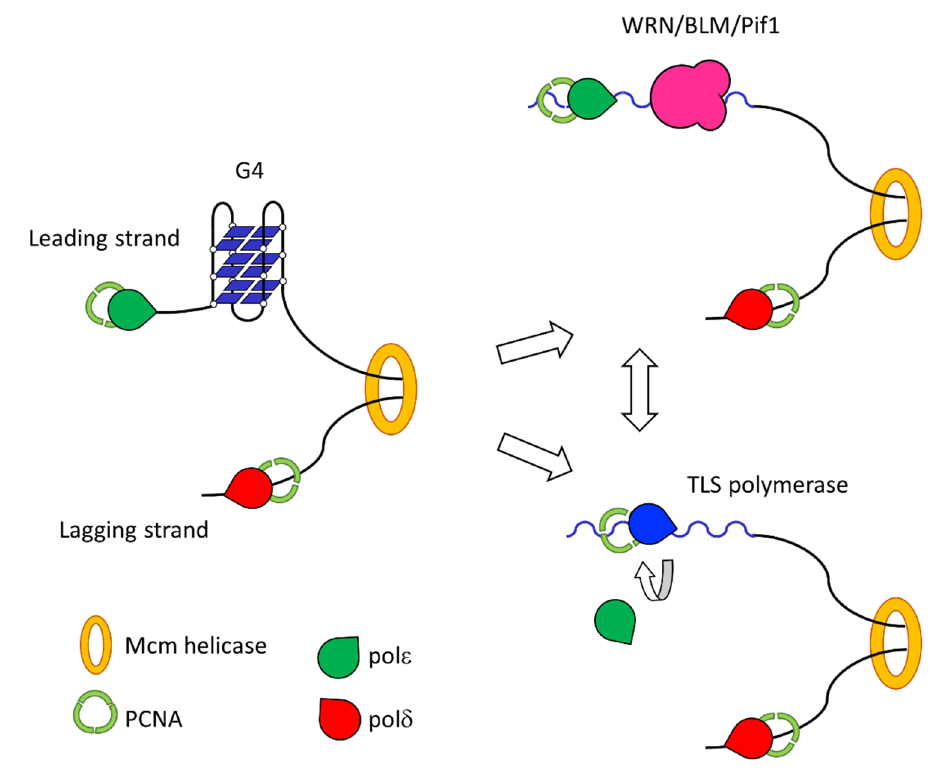
Figure 4. Resolution of G4 motifs after replication fork block. The presence of a G4 motif can impair the movement of the replication fork (left panel). This block can either be resolved by helicases (upper right panel) or by a switch between replicative and Y-family polymerases (lower right panel). The two mechanisms are not mutually exclusive: helicases may melt the G4 that TLS polymerases may then bypass.